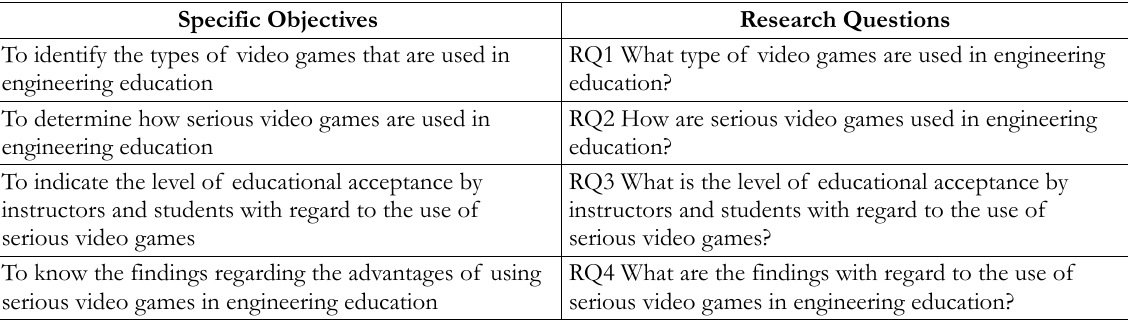
Table 1. Objectives and research